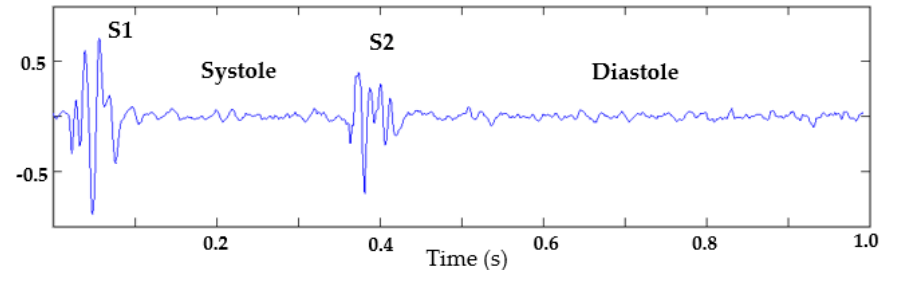
Figure 1. Example signal for a normal heart sound.